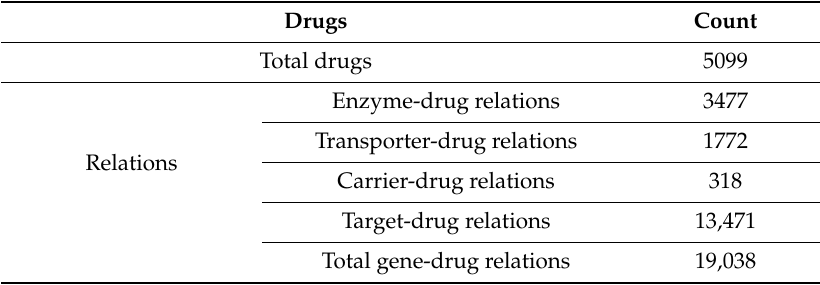
Table 1. Number of drugs and gene-drug relations used in this